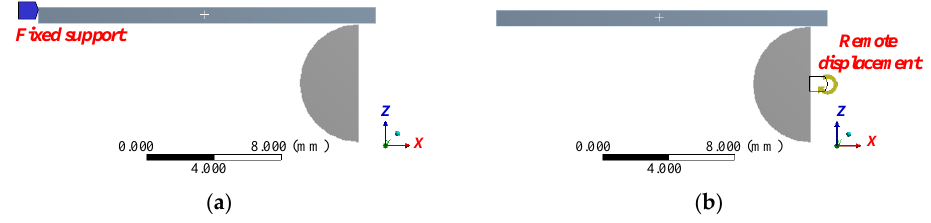
Figure 14. Finite element constraint and load. ( a ) Fixed support. ( b ) Remote rotating angle.